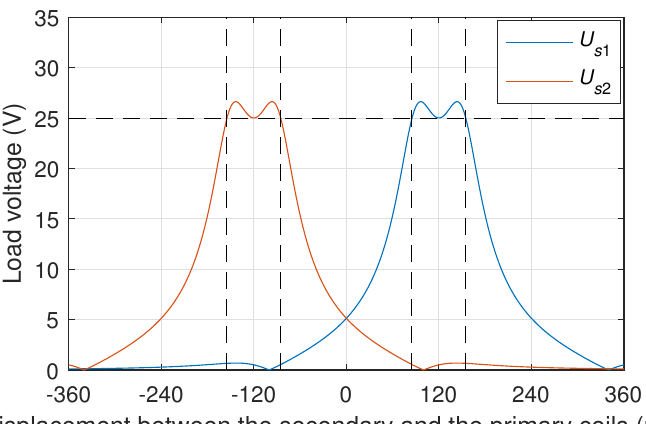
Figure 5. The load voltage simulation diagram of each primary coil working independently.